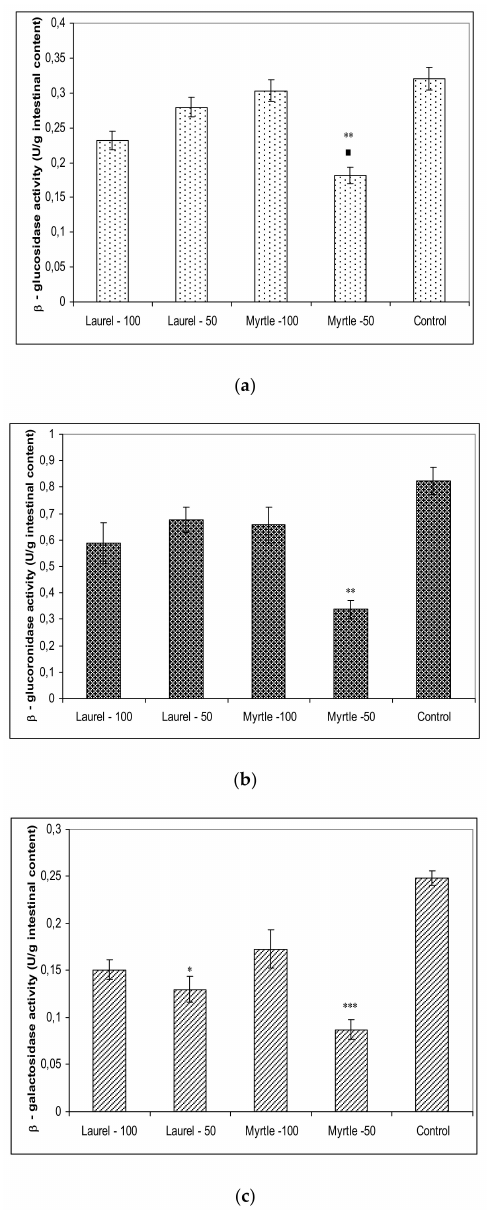
Figure 3. The effect of Laurel and Myrtle extract on faecal bacterial enzymes β -glucosidase ( a ), β -glucuronidase ( b ), β -galactosidase ( c ) activity. Male rats ( n = 5) were administered Laurel and Myrtle extracts ig at a dose of 50 and 100 mg/kg once a day for 14 days. The control group was treated with ig saline. The results are expressed as the mean value of each experimental group ± SE of the mean of two different observations. * Significantly different in relation to control (* p < 0.05; (cid:4) (cid:4) p ** p < 0.01; *** p < 0.001). Significantly different in relation to Myrtle-100 ( <